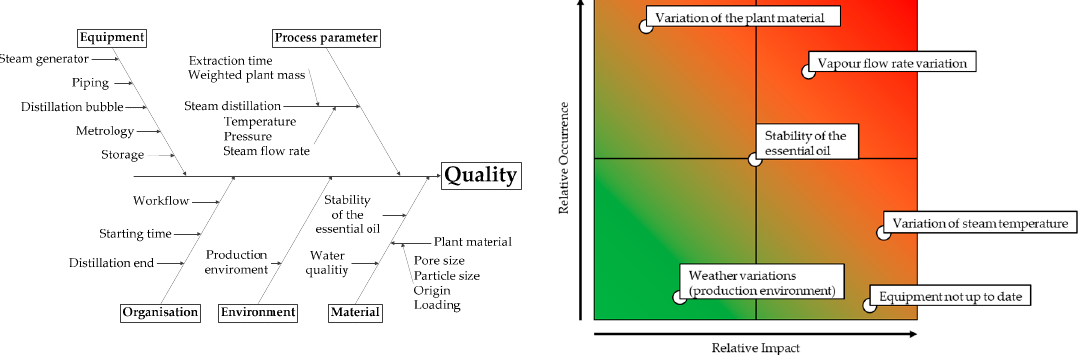
Figure 2. Quality by design (QbD) risk assessment: Ishikawa diagram and failure mode and effects analysis (FMEA).